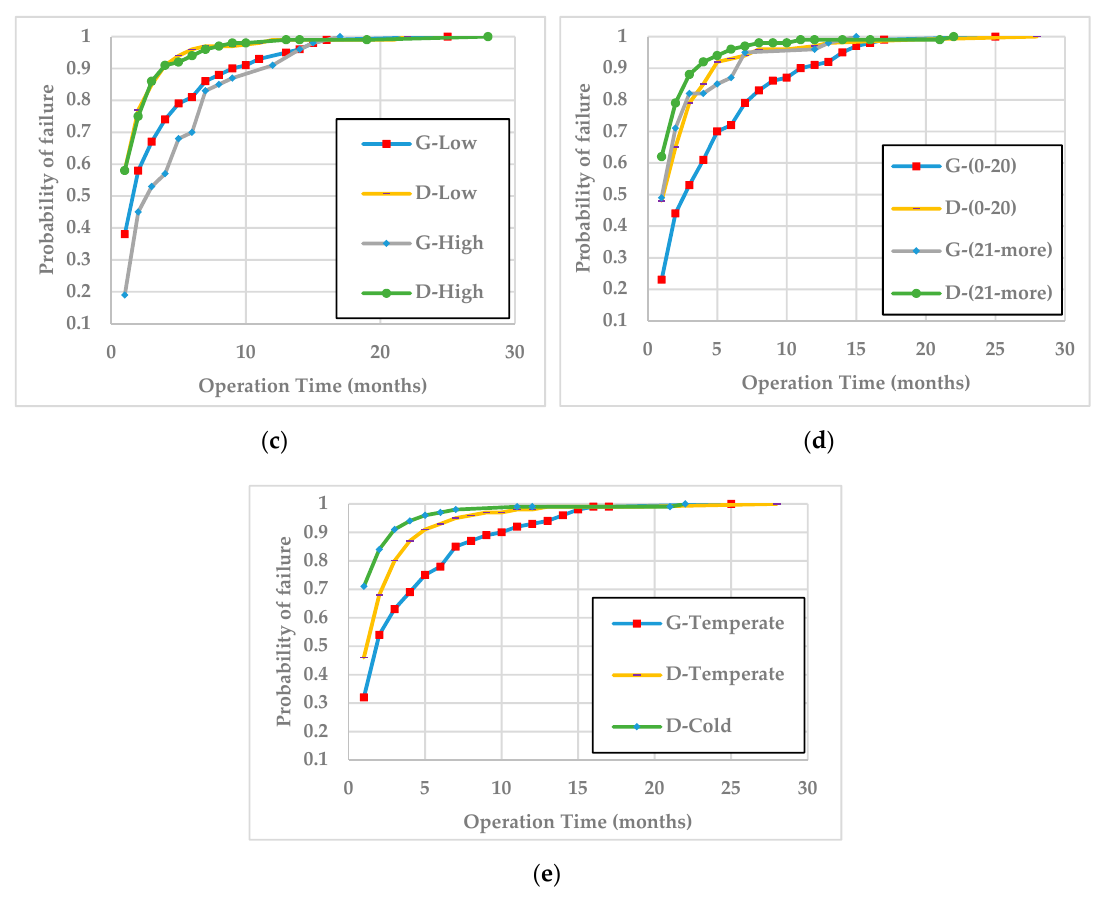
Figure 3. Time-to-failure of wind turbines based on operational and environmental factors. ( a ) Capacity factor, ( b ) geography, ( c ) mean annual wind speed, ( d ) number of previous failures, ( e ) climatic region. (The en dashes here and in the Figures 4–7 mean “with” the other condition(s) except for the numbering ranges for NOPF.)